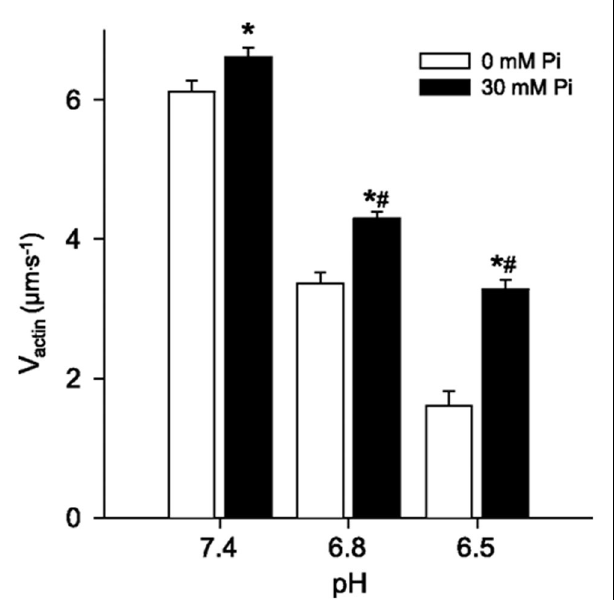
FIGURE 4 |The effect of P i at low pH on V actin . In vitro motility actin filament velocities from chicken skeletal myosin and actin under various levels of pH and P i .Values represent mean ± SEM for V actin at each pH and P i level. Data were analyzed using a two-way ANOVA, * indicates significantly ( p < 0.05) different from 0mM P i and # indicates a significant interaction, meaning that the increase in V actin in response to P i was greater at both pH 6.8 and 6.5 than at 7.4. Figure from Debold et al. (2011), reprinted with permission from the American Physiological